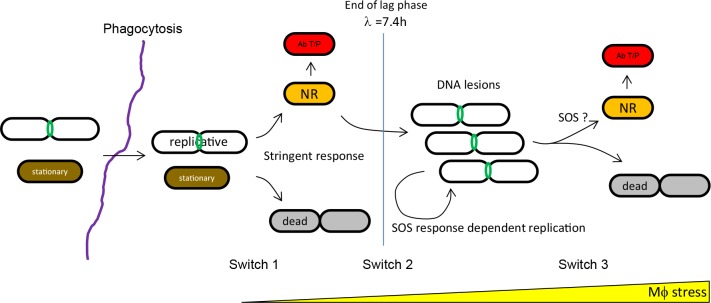
Dynamic of AIEC LF82 bacterial population during macrophage infection.Upon phagocytosis both replicative (green FtsZ ring) or stationary phase (brown) LF82 detect a signal, perhaps nutrient depletion, that led to stringent response activation. This activates a first phenotypic switch toward a non-replicating state (orange) that protects LF82 from dying because of initial stress burst. Among these non-replicating LF82 persisters are formed. After this lag phase, a second switch is required to initiate few rounds of replication. The timing and perhaps the frequency of switching from lag phase to replicative phase differentiate LF82 from our control commensal strain. We have not yet identified LF82 specific determinants that allow this switch. Subsequent replication rounds are dependent on the DNA repair machinery. A third switch, linked to the increasing stress or lesions, is turned on in a portion of the replicative population to form new non growers and persisters. The SOS response might also be playing a role at this stage.